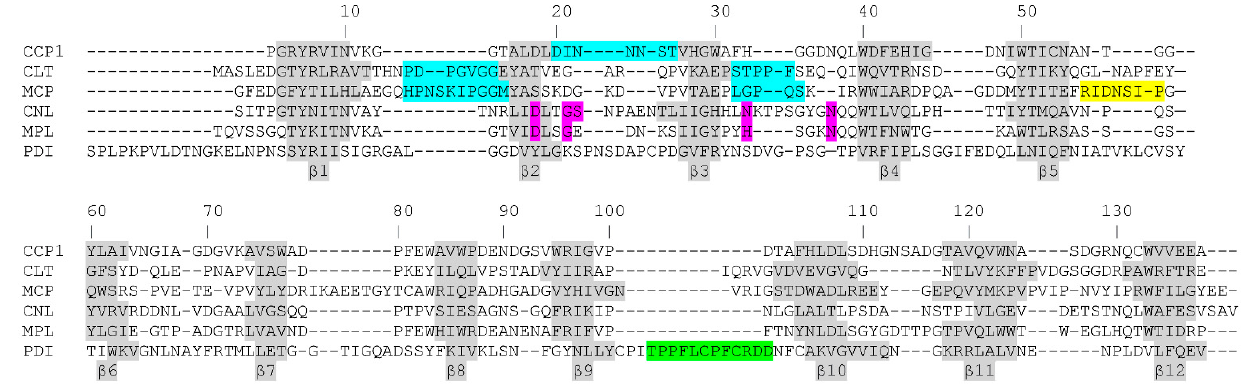
Figure 4. Structural alignment of cocaprins with mycocypins and selected lectins. The β -strands are shown on a gray background, and the loops involved in inhibition of cysteine proteases are highlighted in cyan, those involved in inhibition of trypsin or legumain in yellow, putative loops involved in inhibition of cathepsin D in green and glycan binding residues are highlighted in pink. CCP1, cocaprin (7ZNX), Clt, clitocypin (3H6R), Mcp, macrocypin (3H6Q), CNL, Clitocybe nebularis lectin (3NBD), Mpl, Macrolepiota procera lectin (4ION), PDI, Potato Cathepsin D Inhibitor (5DZU).